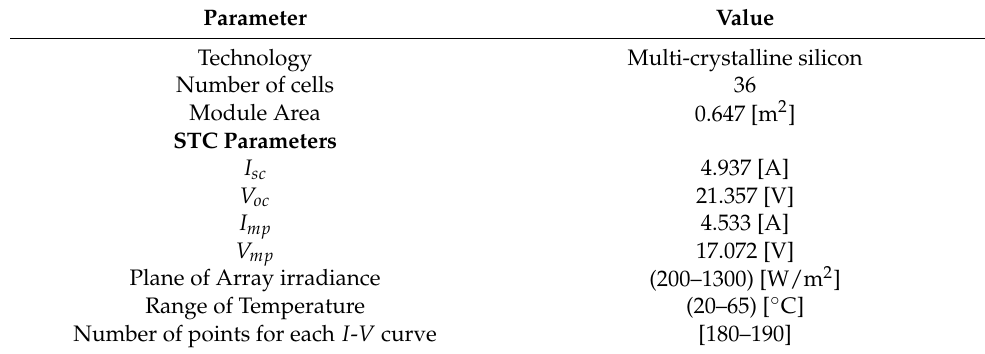
Table 1. Characteristics of the PV panel under study and ranges of the data